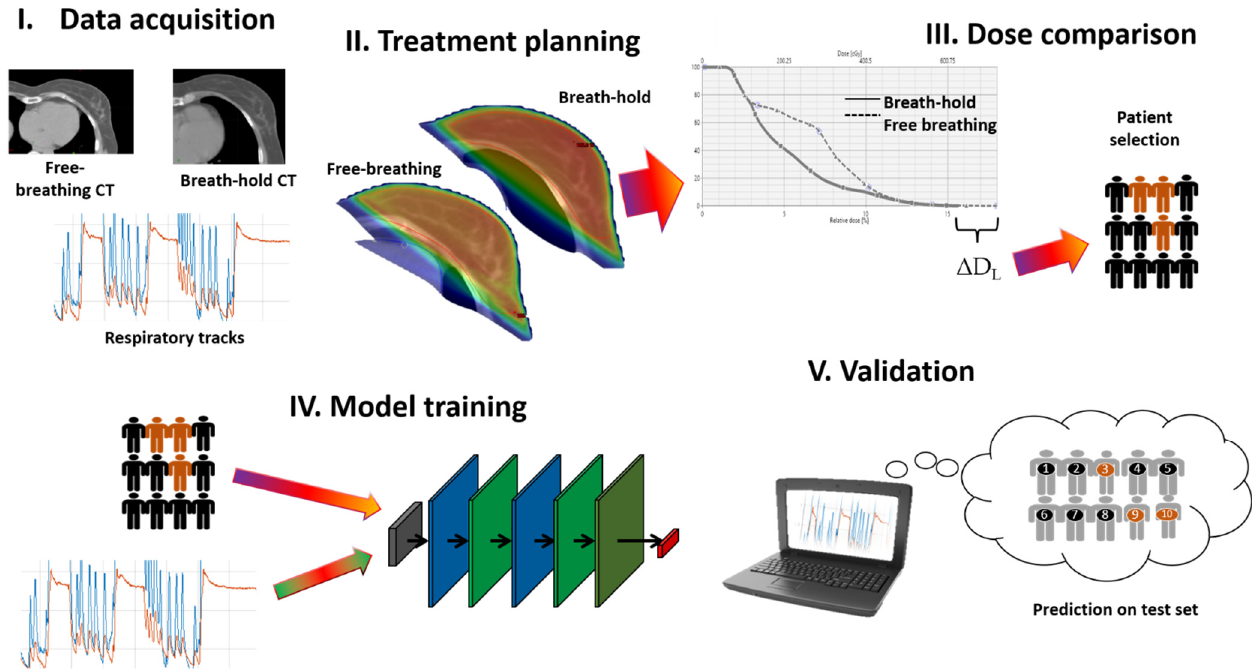
Figure 1. Flowchart which summarizes the main steps in the workflow of the present study. In order to assess the dosimetric benefit of DIBH in terms of dose to the organs at risk for cardiovascular disease, for each DIBH patient a treatment plan was also calcu- lated on the CT acquired in the FB modality, as shown in the Figure 2. The decrease in the maximum dose to the LAD, Δ D L , and between the DIBH and FB plan, was calculated, and its median value, med ( Δ D L ) among the patient cohort was used to split the patients into two classes with lower/higher Δ D L . The patients with Δ D L higher than med ( Δ D L ), were considered eligible for DIBH. For better dosimetric comparison, we also collected dose indexes of the planning target volume (PTV) and organs at risk. These included the minimum dose covering at least 95% of the PTV, V95%, and, for the organs at risk, the V15%, the hottest dose level covering at least 15% of the organ for the lung, and the maximum dose, Dmax, to the heart and contralateral breast. Table 1. Treatment and patient data of the cohort in the study. Variable Value Sex Female Age mean (95%CI) 52 (41, 69.5) Prescribed dose